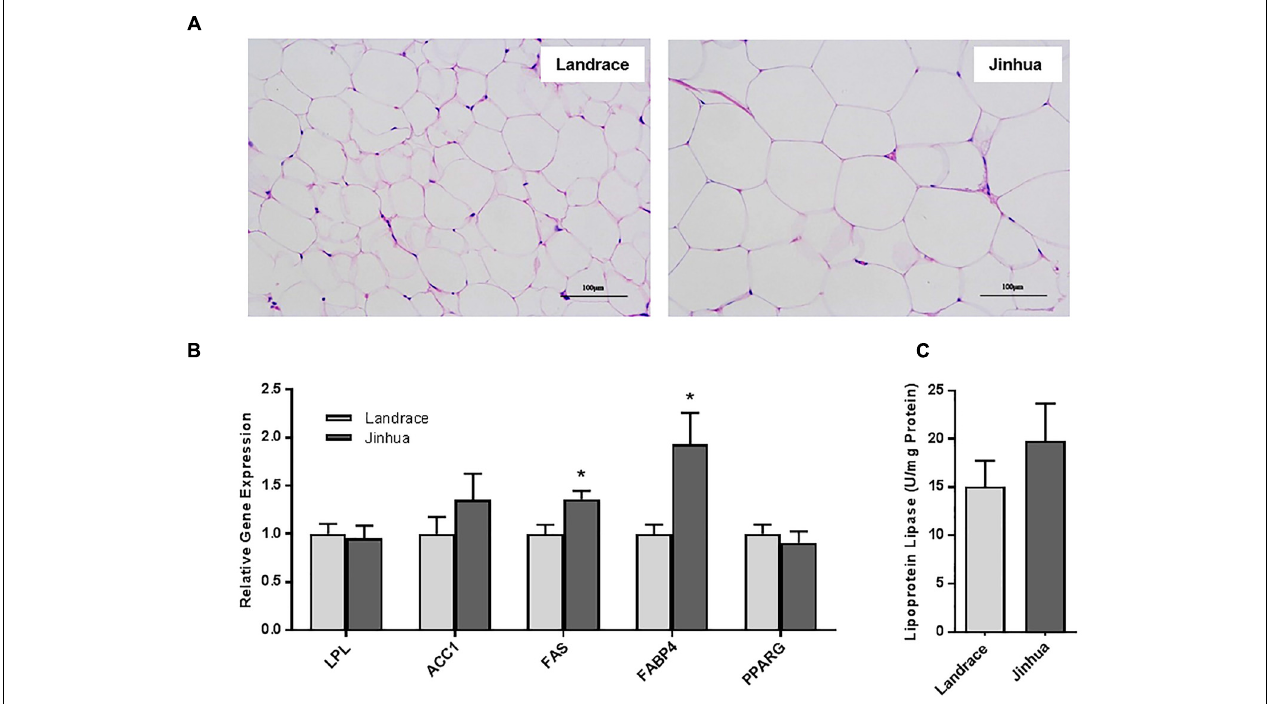
FIGURE 2 | Fat deposition and lipogenesis in the abdominal fat tissue of Landrace and Jinhua pigs. (A) Representative pictures of the abdominal fat sections stained with hematoxylin and eosin (magnification: 200 × ). (B) Relative expression levels of several major lipogenic genes in the abdominal fat of two breeds of pigs. (C) The lipoprotein lipase activity in the abdominal fat of Landrace and Jinhua pigs. The results were shown as means ± SEM of 10 pigs. ∗ P < 0.05 (by unpaired Student’s t -test).